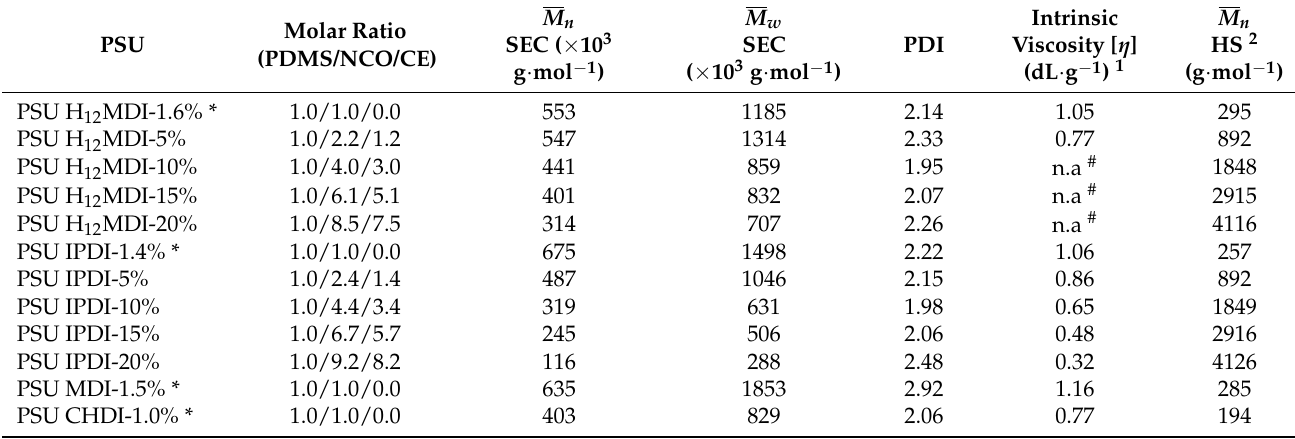
CE: chain extender (APTMDS); PDI: polydispersity index. 1 Intrinsic viscosity was calculated from Huggins plots (see Figure A2 in Appendix B). Values were taken from the intercepts of the fitting curves. # No linear relationship was obtained for the PSUs H 12 MDI-10% and H 12 MDI-20%. 2 The theoretical number average molecular weight of the HSs (g · mol − 1 ) was calculated from the reaction stoichiometry. * No chain extender was included in the polymer, and the HS molecular weight resulted from the diisocyanate + terminal urea groups formed by the amino groups of the PDMS. PSU elastomers from H 12 MDI and IPDI were synthesized from a PDMS of M n : 16,338 g · mol − 1 . The PSU copolymers from MDI and CHDI were prepared from a PDMS of M n : 16,296 g · mol − 1 and M n : 16,472 g · mol − 1 , respectively. (Average values were determined from four titrations). Table 2 presents the molar ratios of the monomers used for the synthesis of PDMS- based polyurea elastomers, the molecular weights determined by SEC, and [ η ] values. Furthermore, the theoretical number average molecular weights ( M n ) of the HSs, which were calculated according to the reaction stoichiometry, are also